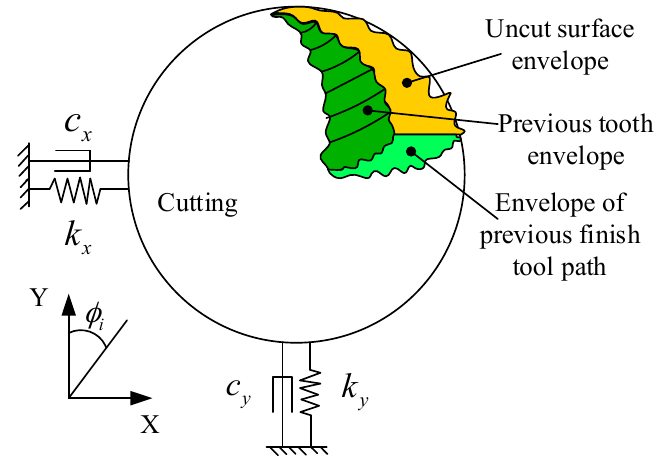
Figure 3. Swept surfaces of one cutting edge along two adjacent tool paths.